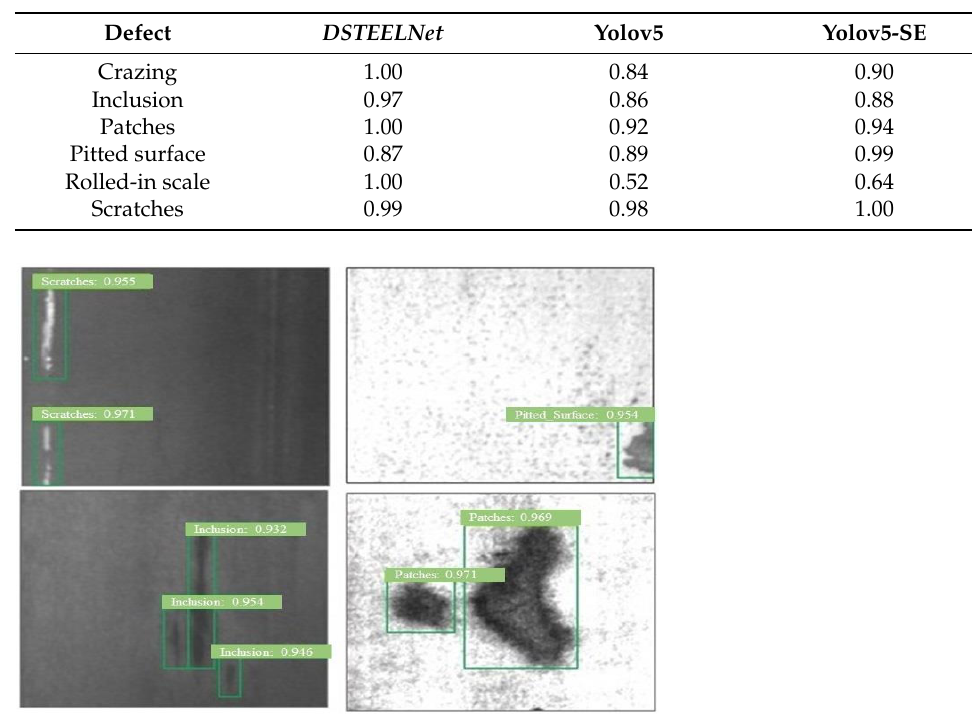
Figure 10. Confusion matrices for DSTEELNet , and ResNet50 on test GNEU dataset. Figure 10a shows that DSTEELNet detects all the steel surface defects perfectly except the inclusion defects. It misclassified 13 inclusion defects out of 90 as pitted_surface. Furthermore, as shown in Figure 10b ResNet50 misclassified 31 inclusion defects out of 90 as pitted_surface. In summary, DSTEELNet fails to detect 2.9% of defects in 540 im- ages however, ResNet50, MobileNet, VGG19, and VGG16 fail to detect defects in 6.6%,